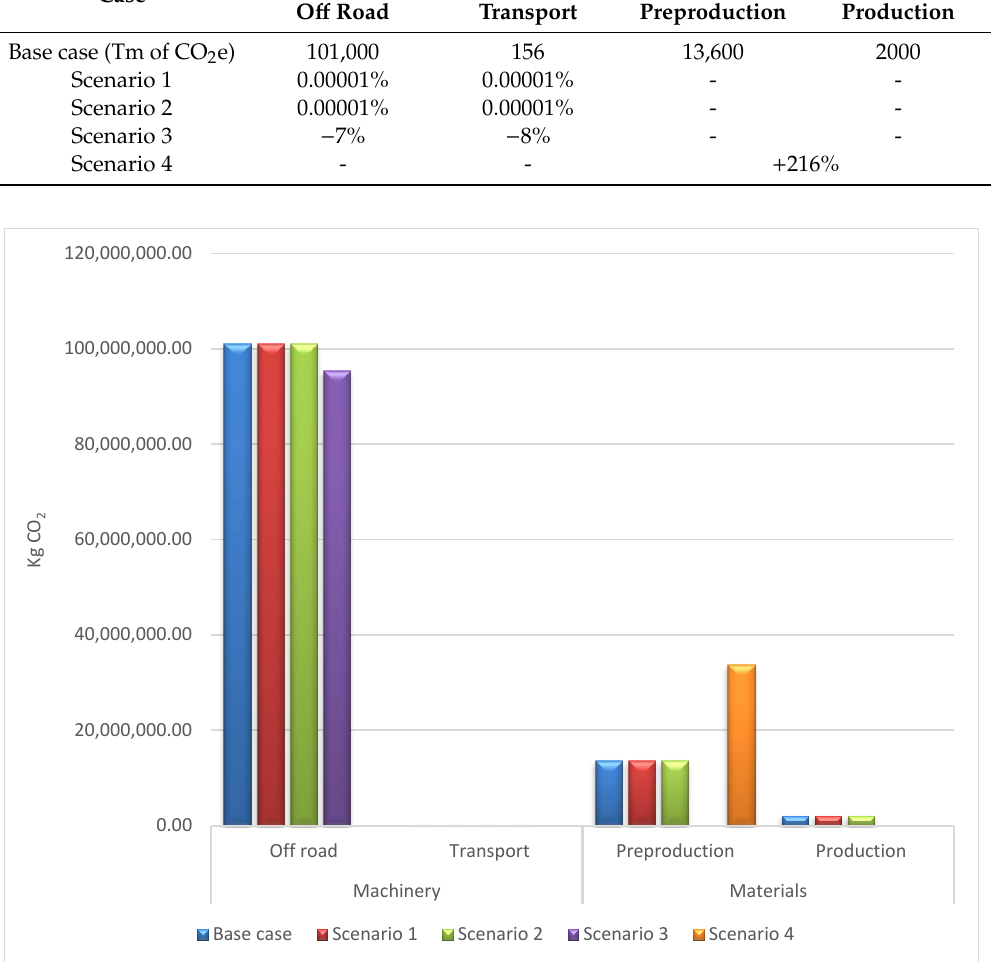
Figure 4. Results of CO 2 kg emissions obtained in each scenario: Construction phase.